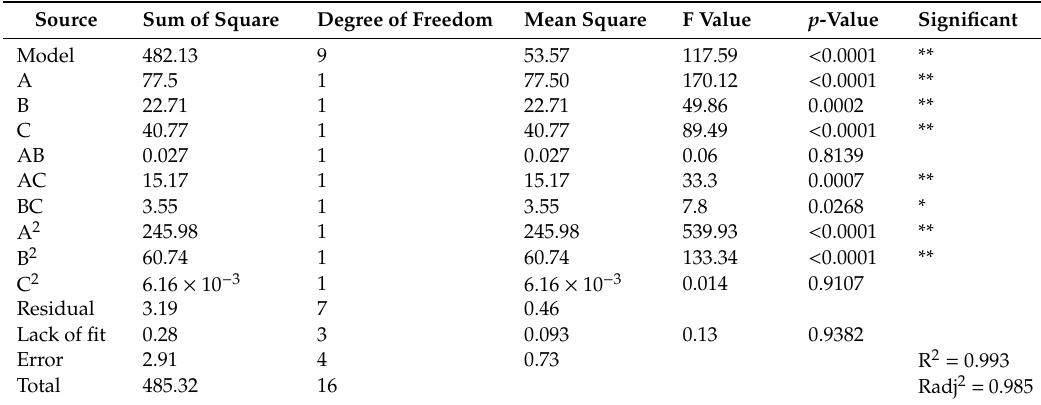
Table 1. ANOVA analysis of Box-Behnken